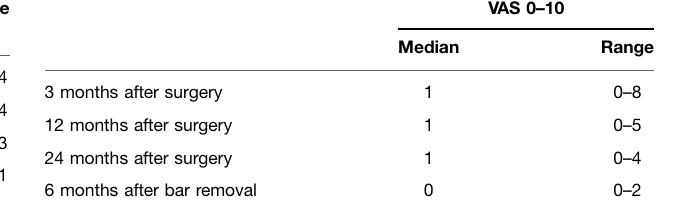
TABLE 3 | Results of the quality-of-life questionnaire after MIRPE. Quality of life (no. of patients), %